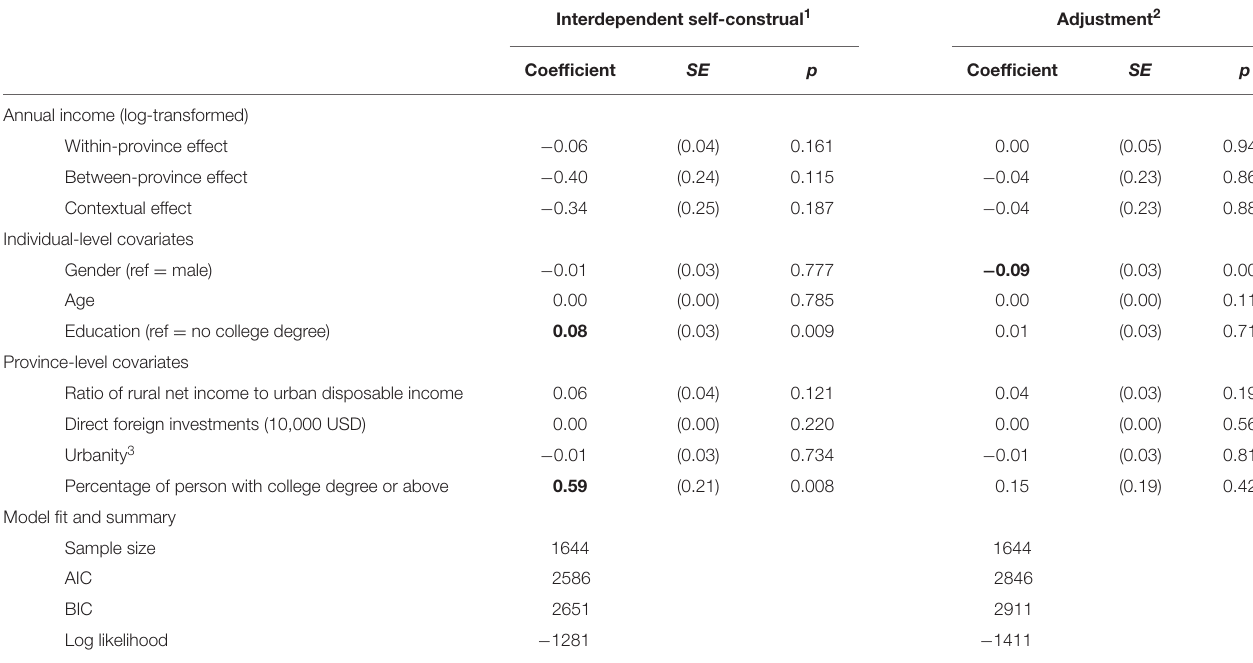
TABLE 4 | Multilevel analyses of interdependent self-construal and